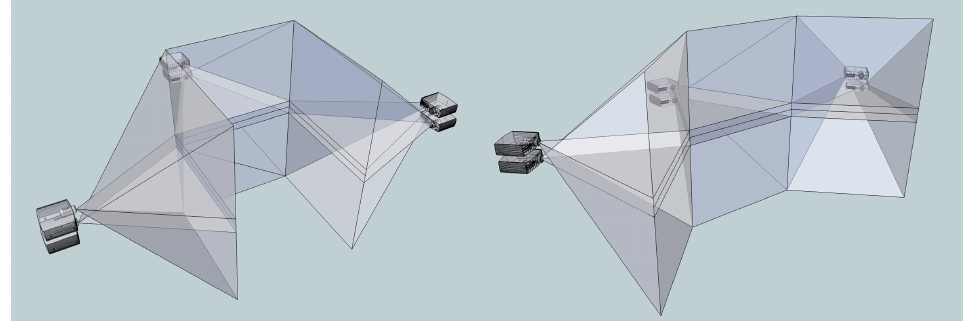
Figure 6. Two different display setups with three flat screens and six projectors.